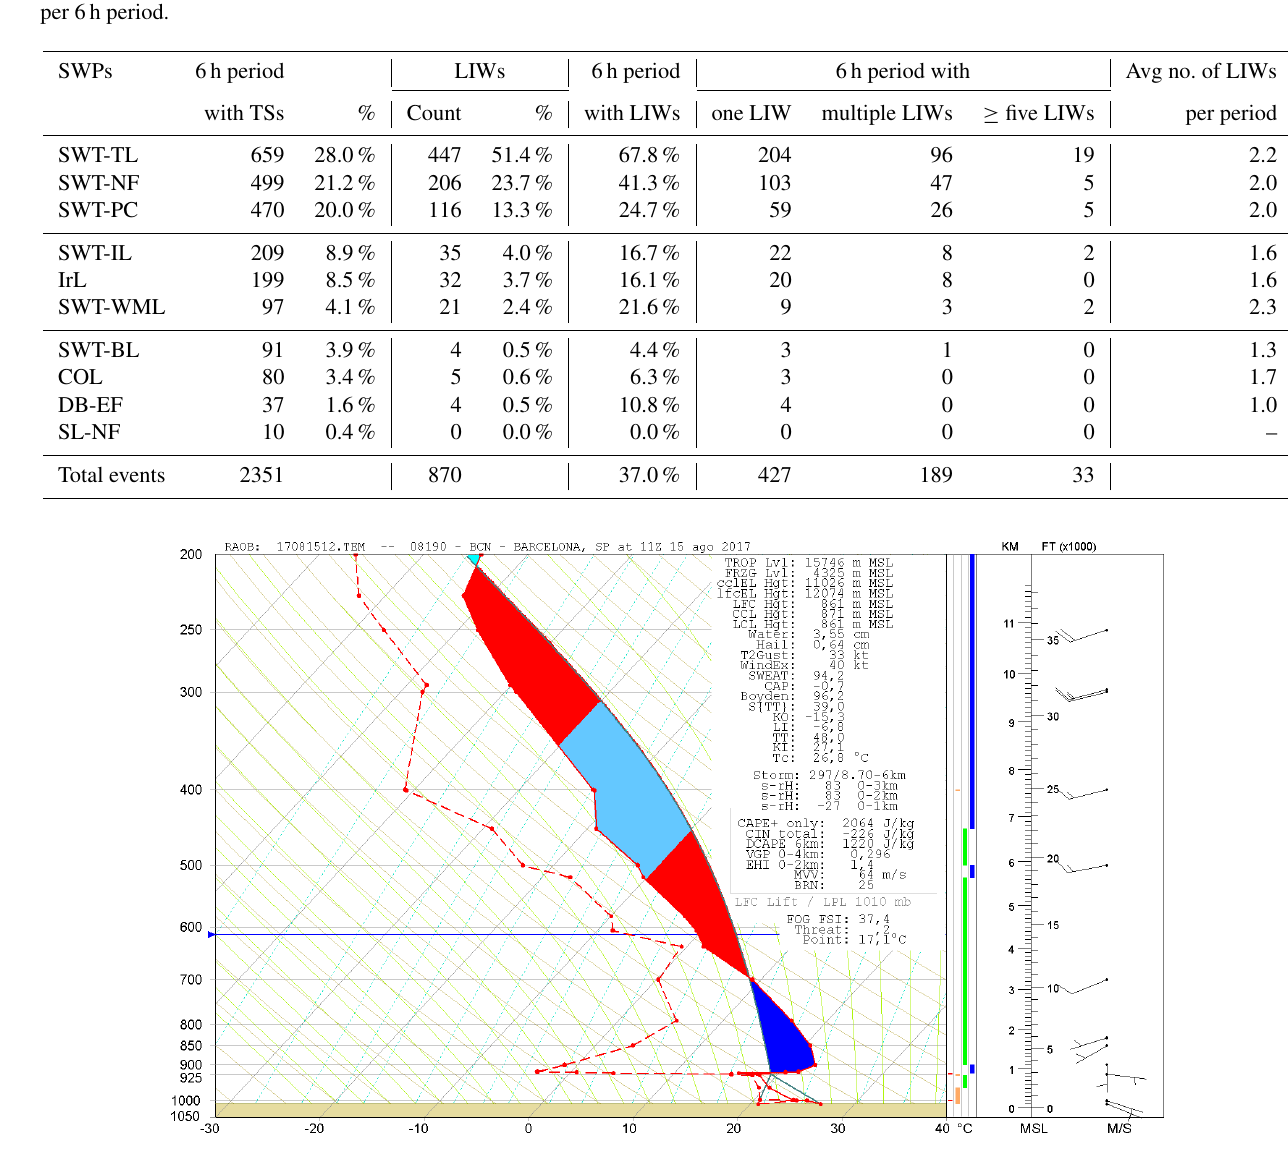
Table 1. SWPs conducive to thunderstorms (TSs) and to lightning-ignited wildfires (LIWs). Columns show event distribution per SWT; LIW events per SWP; 6h periods with LIWs; 6h periods with one single LIW, multiple LIWs or five or more LIWs; and average number of LIWs per 6h period.